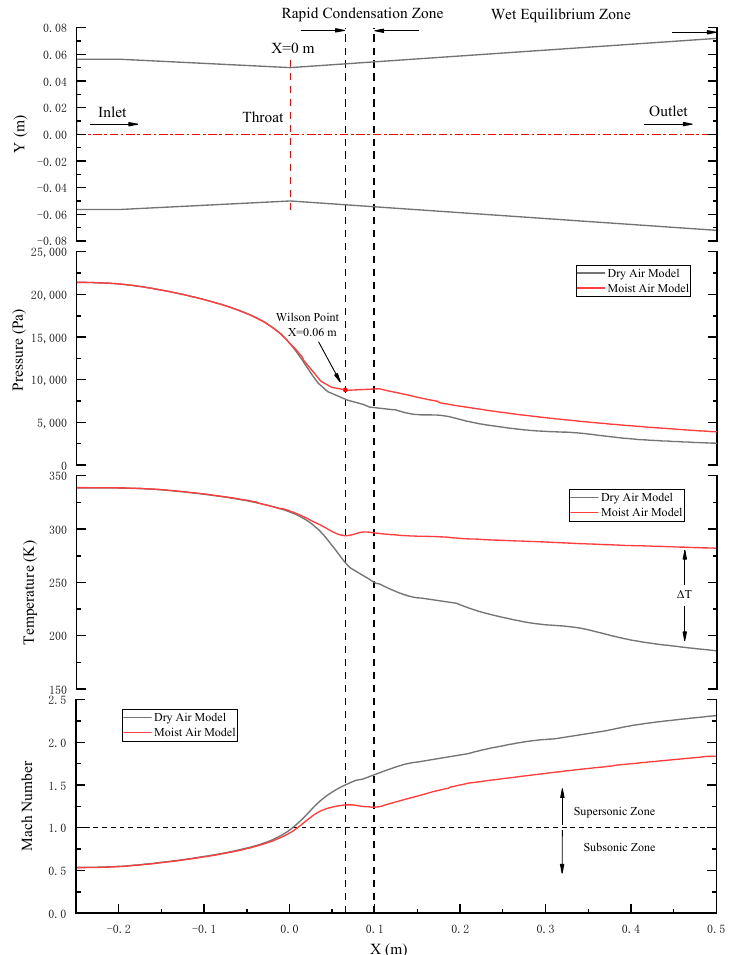
Figure 4. Pressure, temperature and Mach number distribution along the Moore type “B” nozzle centerline.